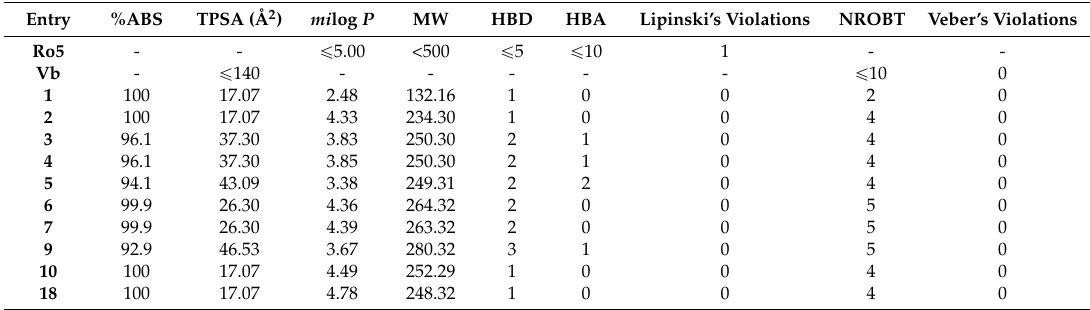
Table 4. Lipinski’s and Veber’s parameters of selected